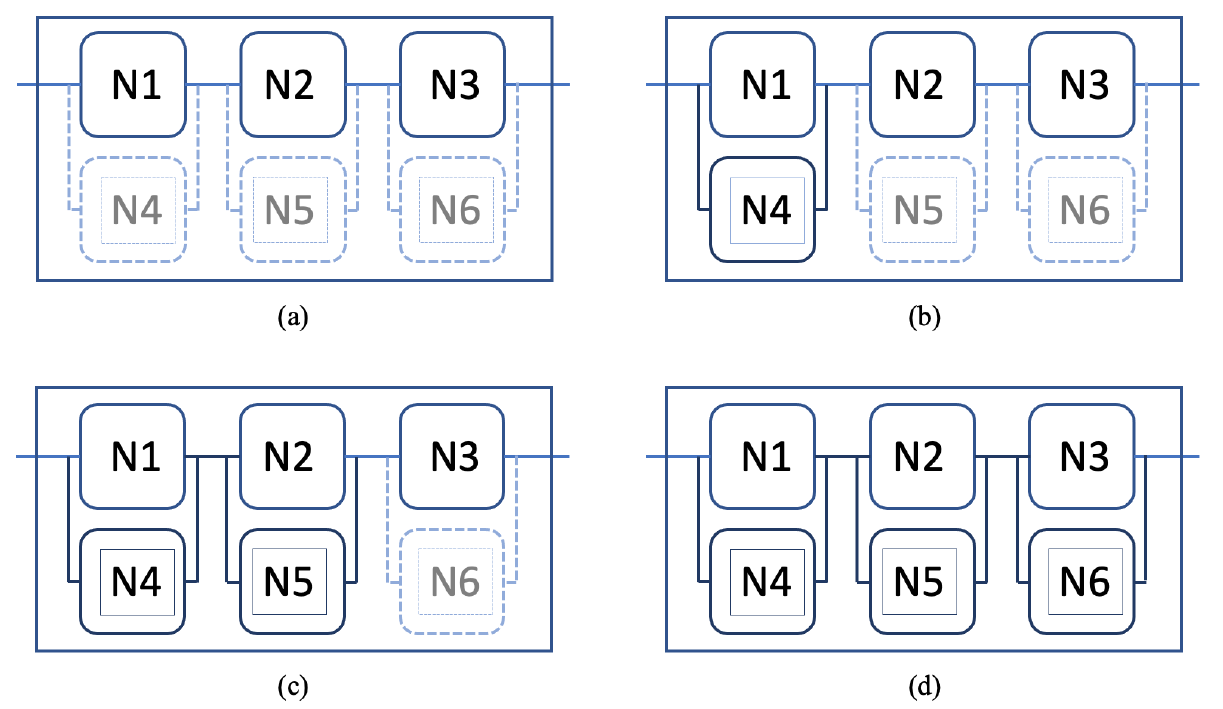
Figure 14. Cloud structure updated with additional nodes for each task. ( a ) The original Cloud-2 with N1, N2, and N3, including the options to add N4, N5, and N6. ( b ) N4 is added after N1’s trust declines. ( c ) N5 is added after N2’s trust declines. ( d ) N6 is added after N3’s trust